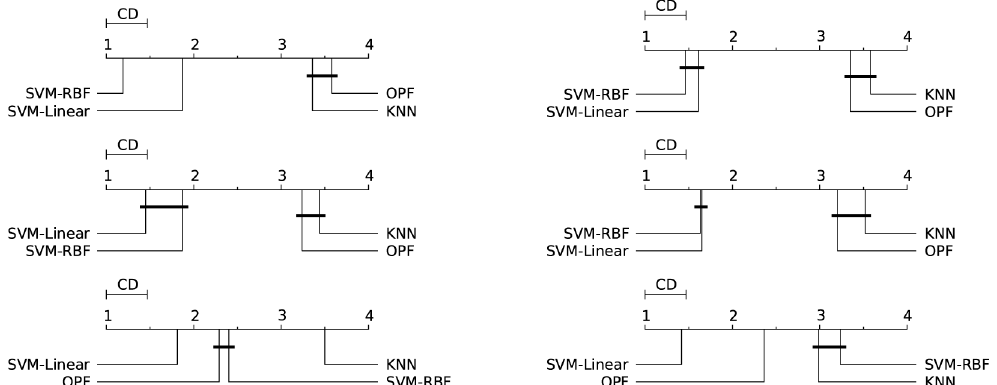
Fig 3. Cod-RNA. Comparison of all classifiers against each other with the Nemenyi test and learning time constraint equals to 1, 5, 20, 60, 300, and 1200 seconds. Groups of classifiers that are not significantly different (at p = 0.05) are